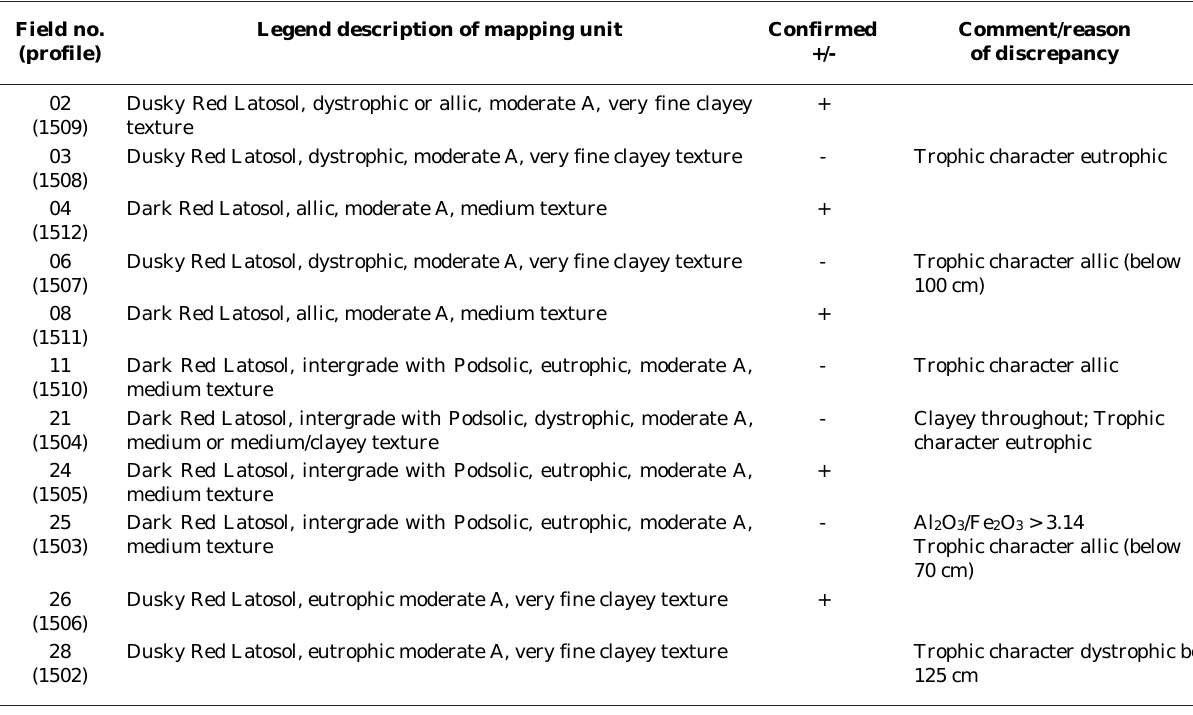
Table 5. Soil profiles in the Assis region typified according to map unit and ground truth